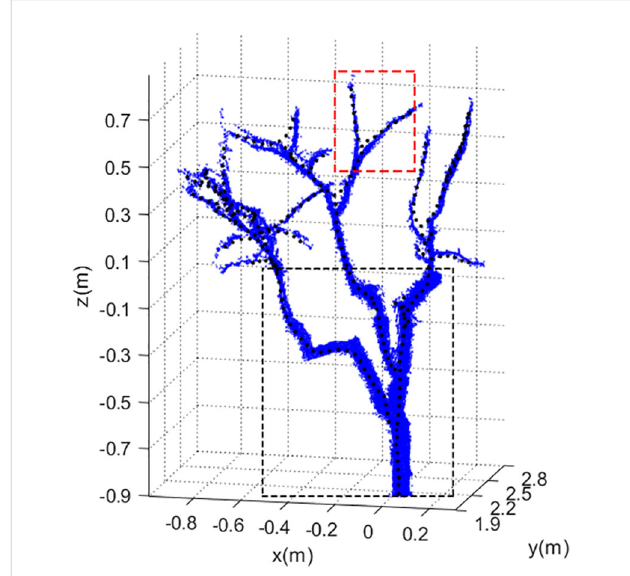
FIGURE 12 Point cloud of jujube tree (blue) and its skeleton